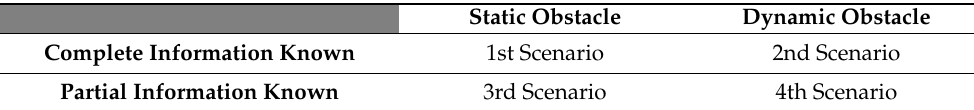
Table 1. Possible scenarios between obstacle types and information available. Static Obstacle Dynamic Obstacle Complete Information Known 1st Scenario 2nd Scenario Partial Information Known 3rd Scenario 4th